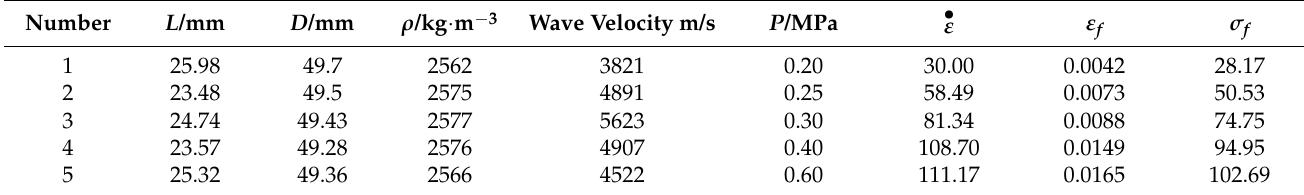
Table 1. Results of single-impact tests.